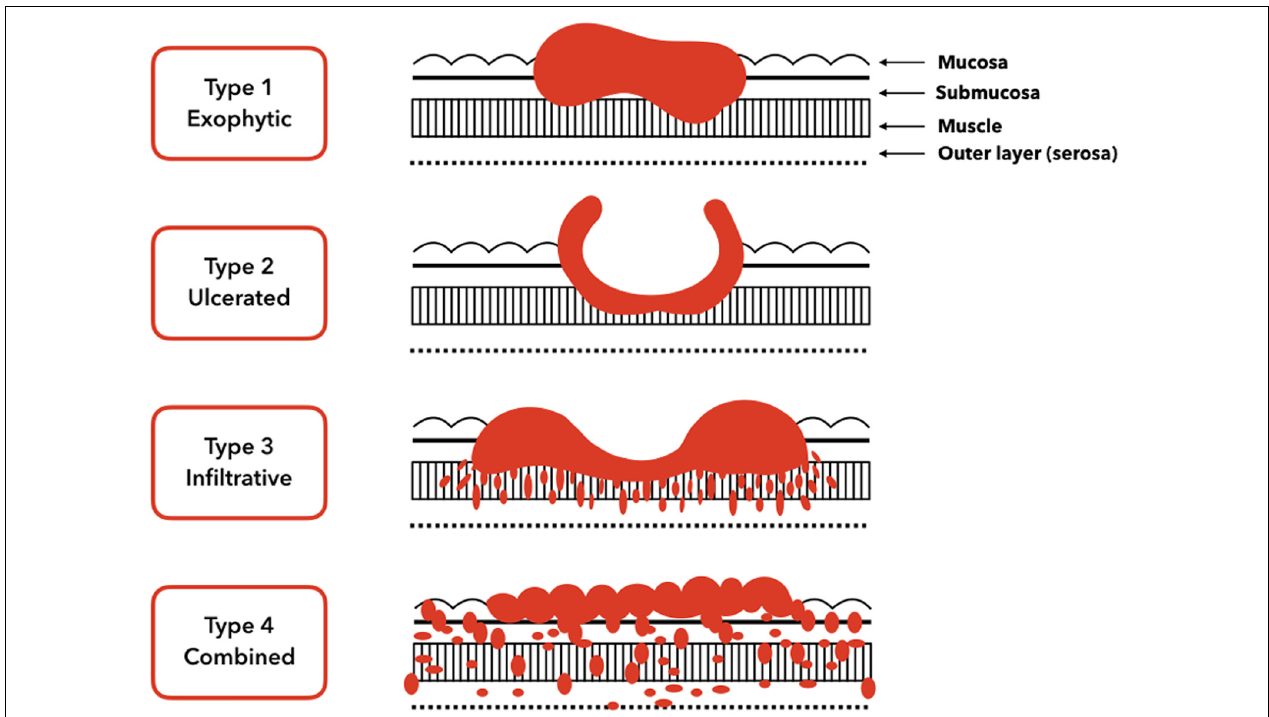
FIGURE 1 | Gross tumor morphology of gastric carcinomas. Type 1 is a classical superficial tumor whereas from type 2 to type 4 tumors are advanced.